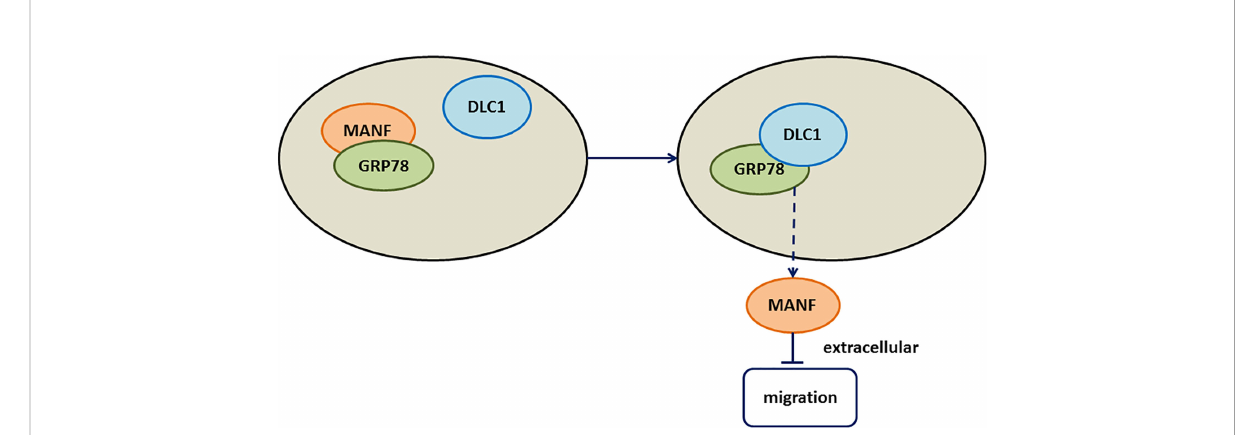
FIGURE 6 Working model. The working model showed that DLC1 interacted with GRP78 to increase the release of MANF, which inhibited wild-type colon cell migration.